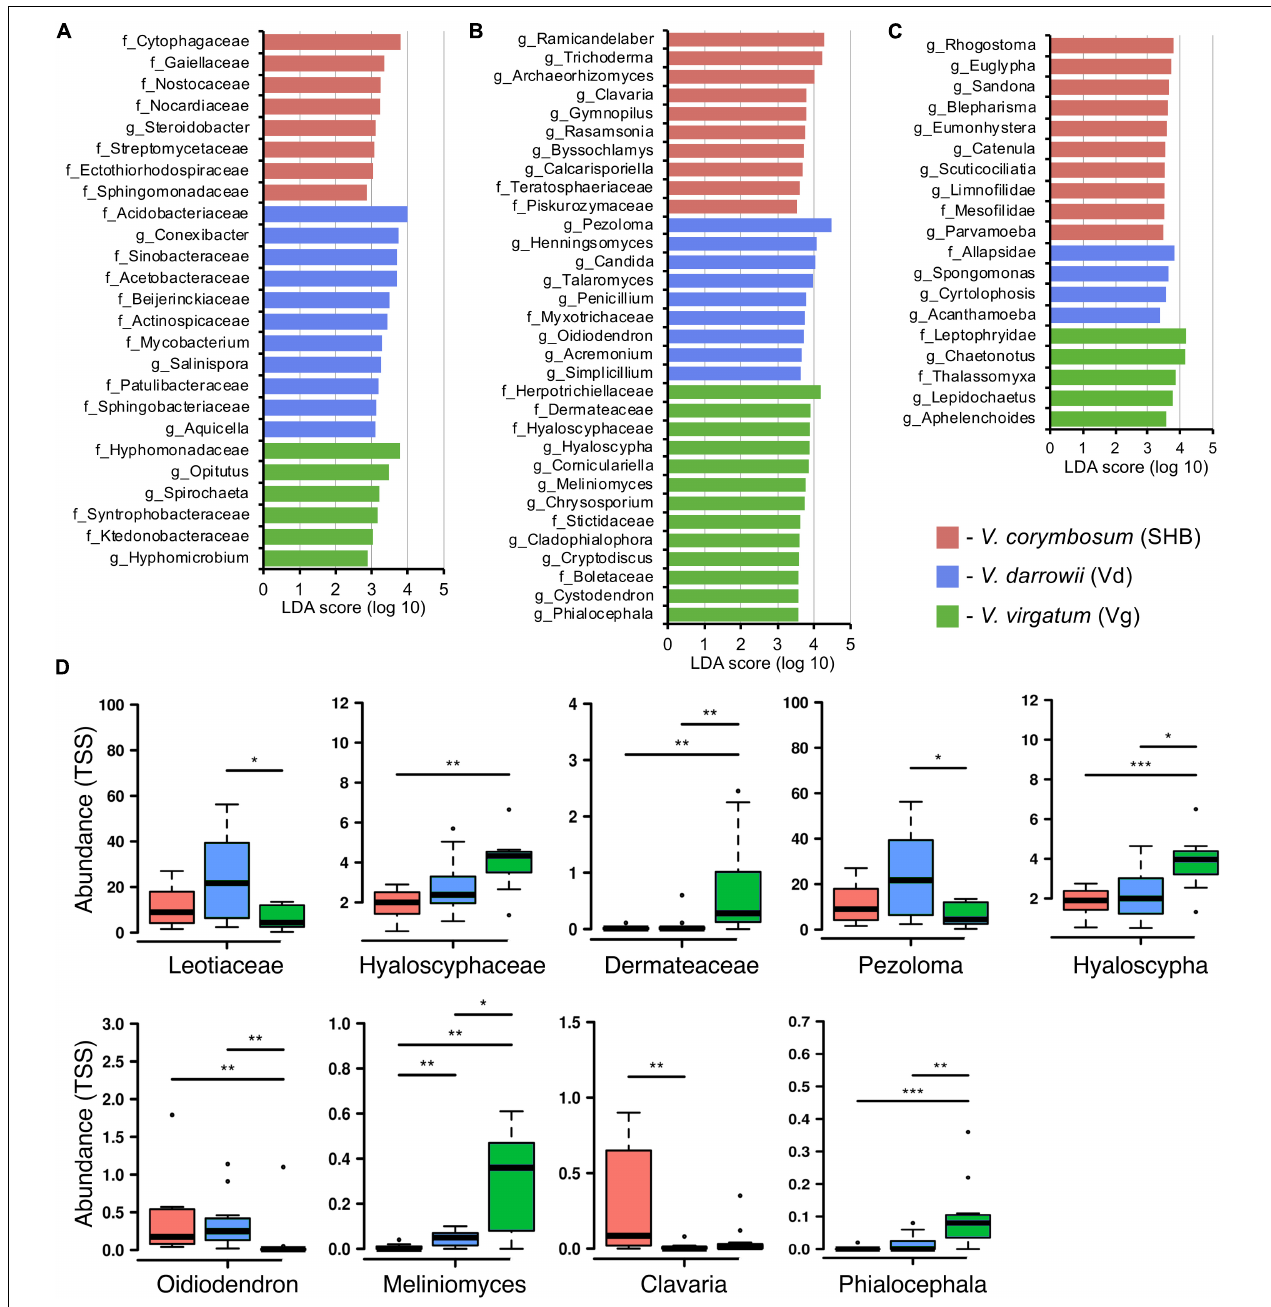
FIGURE 4 | LEfSe analysis of differentially abundant (LDA threshold score ≥ 3.0) families and genera of bacteria (A) , fungi (B) , and eukaryotes (C) between Vaccinium species. (D) Ericoid mycorrhizal fungi with significant differences (* P ≤ 0.05; ** P ≤ 0.01; *** P ≤ 0.001) in the total sum normalized (TSS) transformed